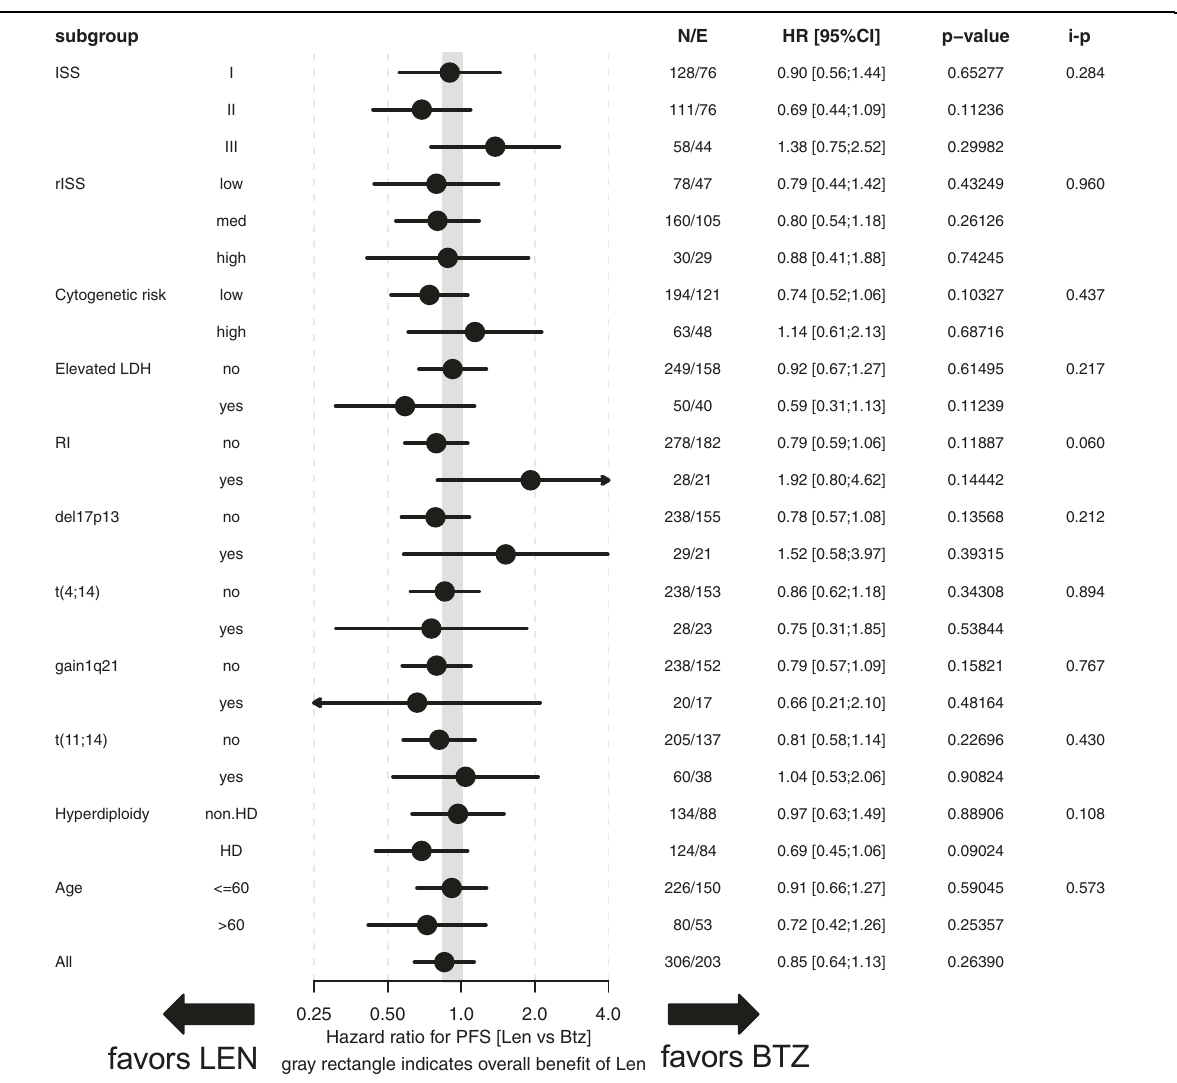
Fig. 2 Subgroup analyses on progression-free survival (PFS) according to baseline factors. Multivariate subgroup analyses adjusted for response (CR/nCR vs.<nCR) were calculated for PFS in the overall cohort. ISS international staging system, rISS revised ISS, cytogenetic risk: high vs. standard [ = low] risk, Elevated LDH (elevated [yes] vs. normal [no]), RI renal impairment, de fi ned as serum creatinine (>2 mg/dl [yes] vs. <2 mg/dl [no]); Hyperdiploidy cytogenetic hyperdiploidy